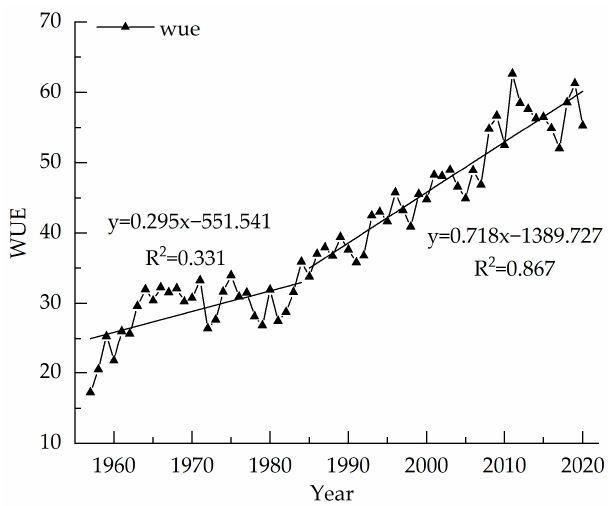
Figure 6. Inter-annual variations of WUE of Picea meyeri on Luya mountain.